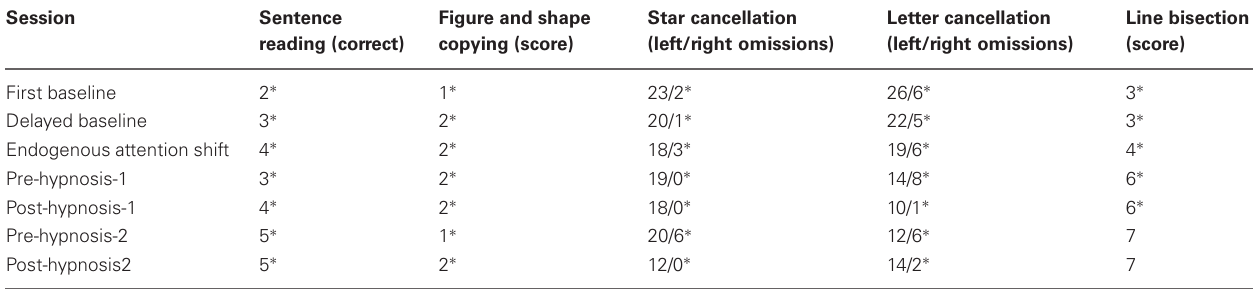
Table 2 | Neuropsychological evaluation of